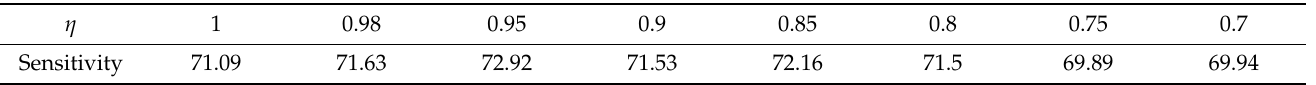
Table 3. Sensitivity of our method at different confidence